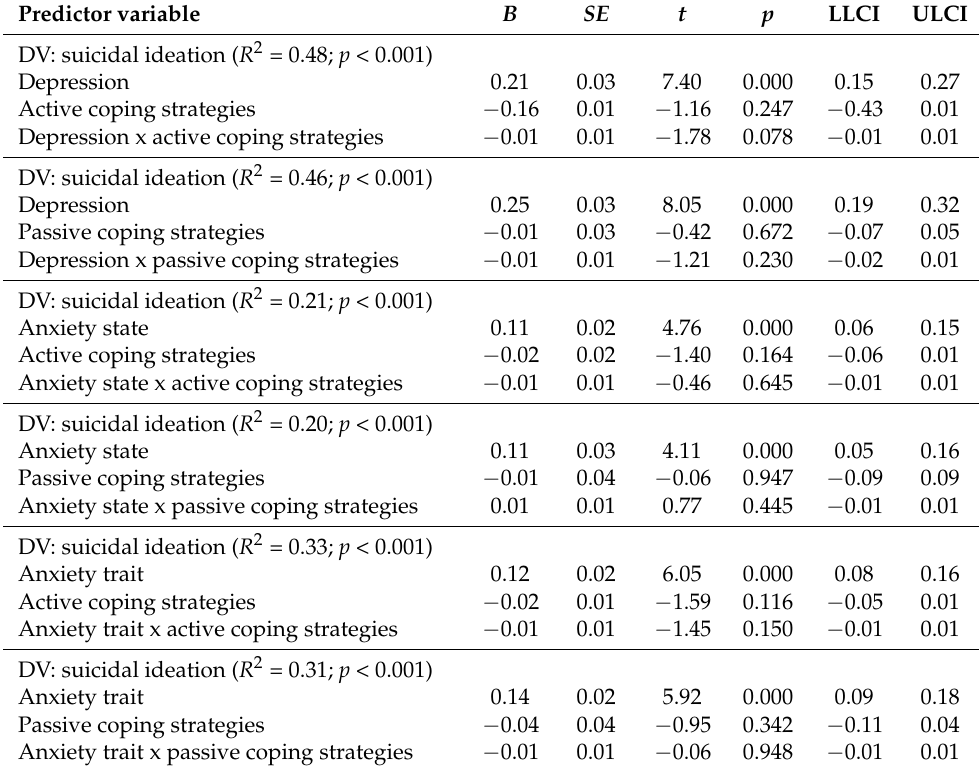
Table 3. Mediation analysis of suicidal ideation with respect to mental health and coping